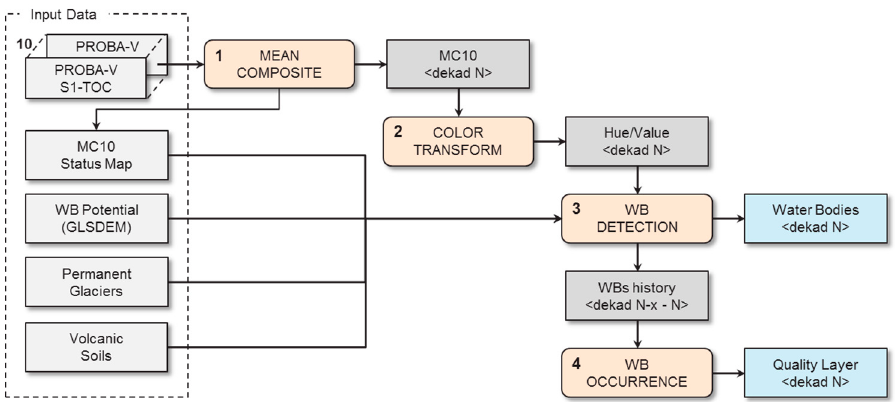
Figure 1. General overview of the Water Bodies Detection Algorithm. Five sets of input data are processed in four main steps to finally obtain two output layers, i.e., the detected water bodies and the water bodies occurrence.